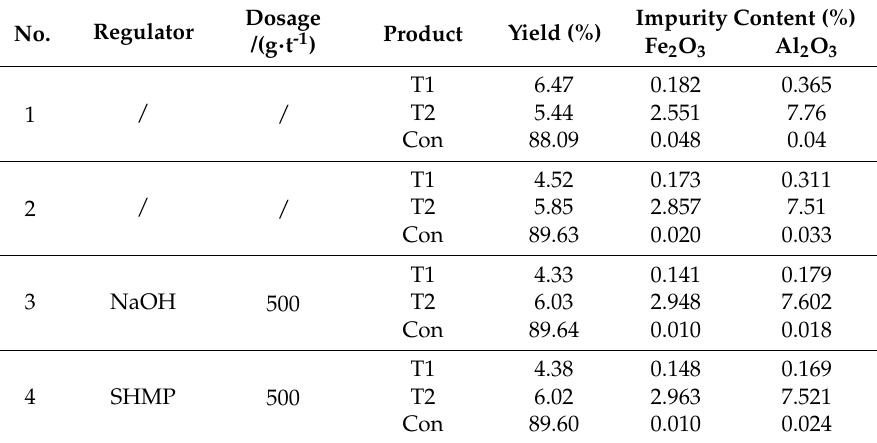
Table 4. Experiments conditions and results.